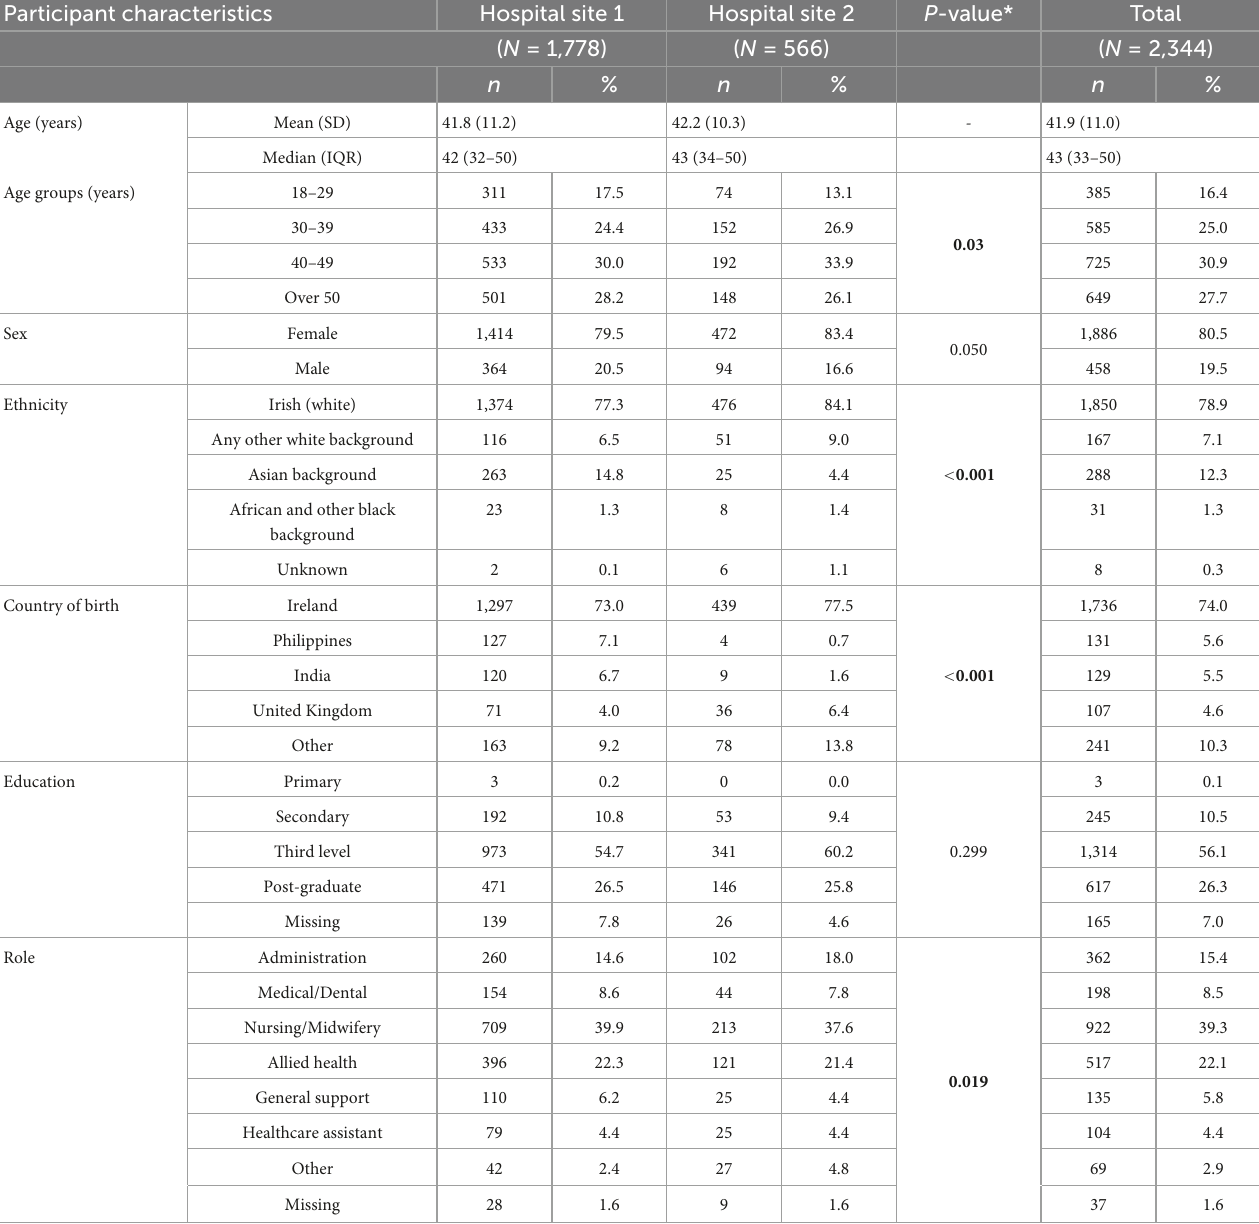
TABLE 1a Participant characteristics by hospital and total study population, PRECISE 4, Ireland, November 2021. Participant